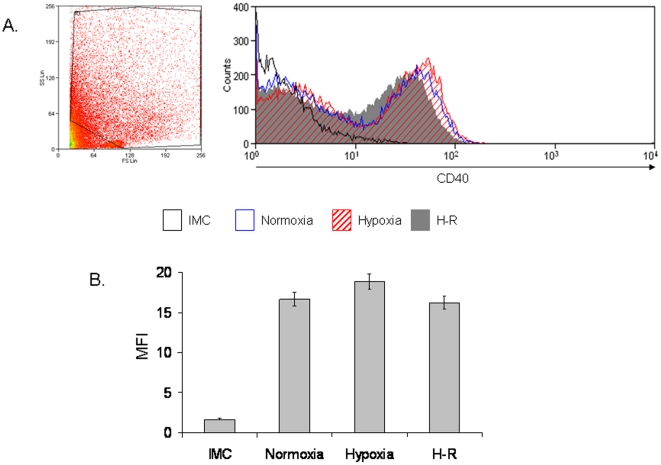
CD40 Expression on Primary Human Hepatocytes.
Figure 1a demonstrates a representative flow cytometry plot of CD40 expression on primary human hepatocytes during normoxia, hypoxia and H-R. The plot on the left hand side represents a typical forward scatter (FS) versus side scatter (SS) plot of primary human hepatocytes. The FS versus SS plots shown is from the H-R sample of a liver preparation but similar plots were obtained during normoxia and hypoxia (data not shown). Figure 1b shows a bar chart with the pooled data of three separate experiments illustrating the level of CD40 expression on primary human hepatocytes. Data are expressed as MFI and readings are based upon values taken from cells within the gated region in Figure 1a.